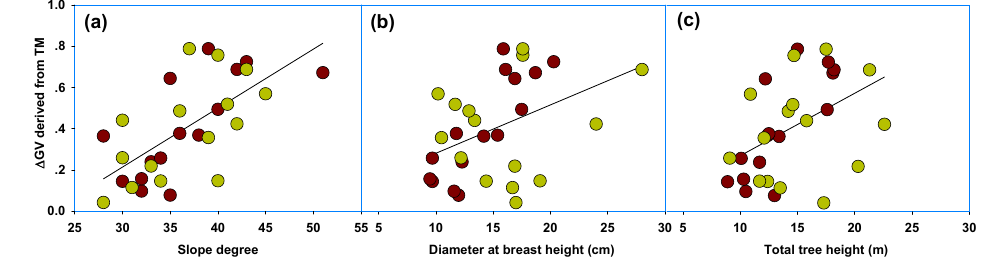
Figure 9. The relationship between Δ GV and terrain slope ( a ); tree’s diameter at breast height ( b ); and tree’s height ( c ). The brown and green points represent deciduous and evergreen forests, respectively.